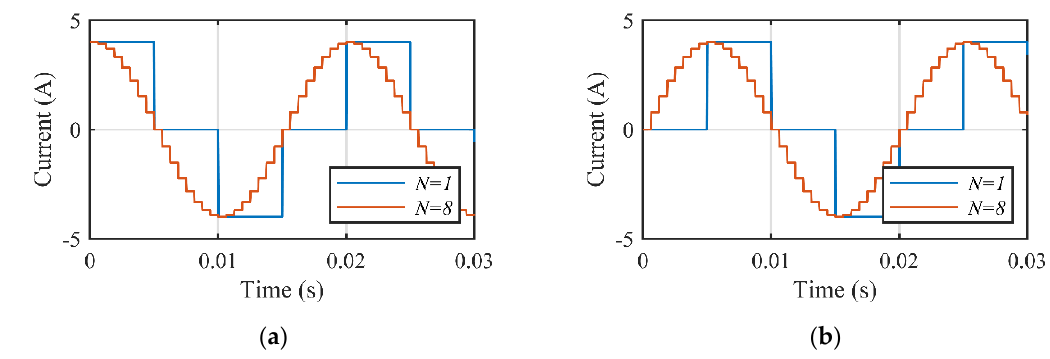
Figure 9. Currents of ( a ) winding A and ( b ) winding B for N = 1 and N = 8.